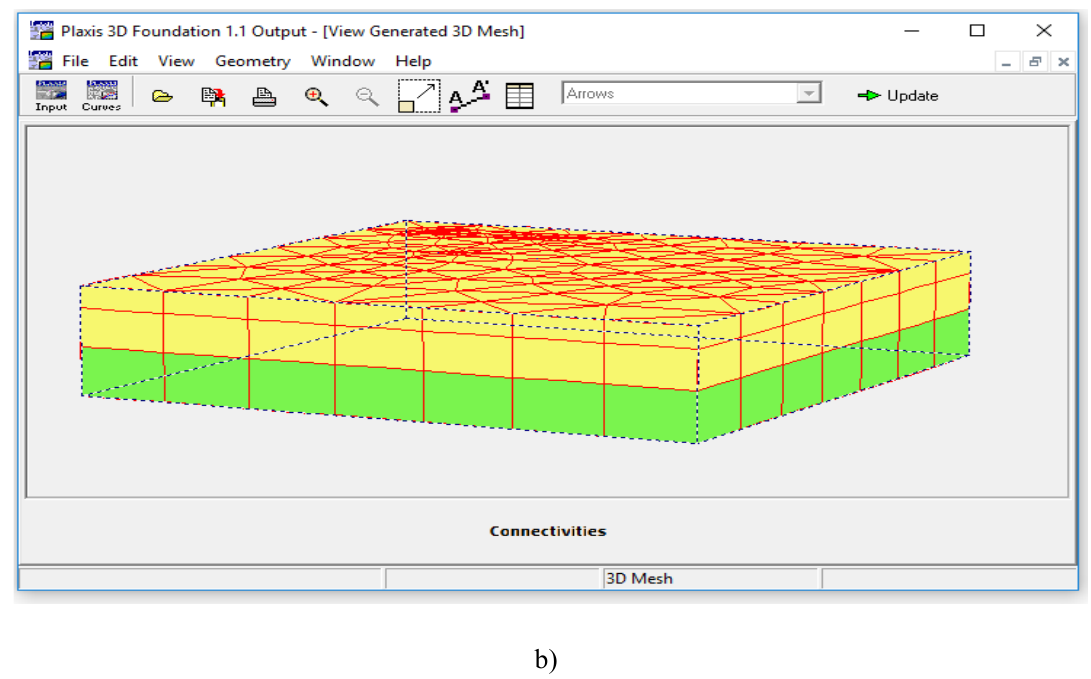
Fig. 9. Generation of mesh for finite elements analysis. a) 2D mesh generate b) 3D mesh generate. Step-7: In calculation mode different phases are generated like excavation, footing loading etc. which are shown in (Fig.10).